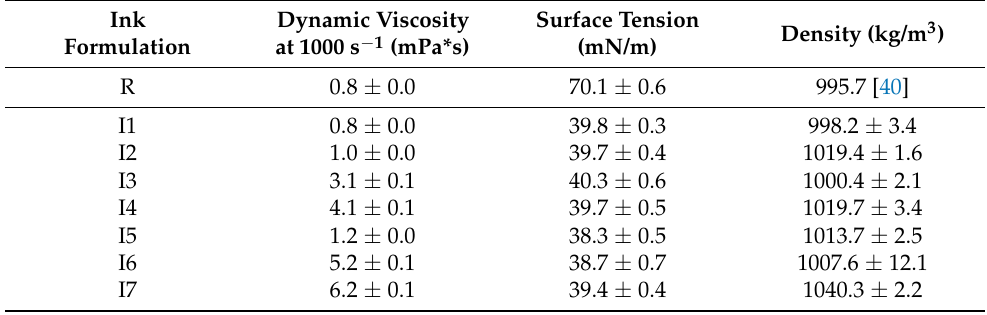
Table 3. Results of physicochemical investigations at 30 ◦ C, mean ± standard deviation (SD) ( n = 3).